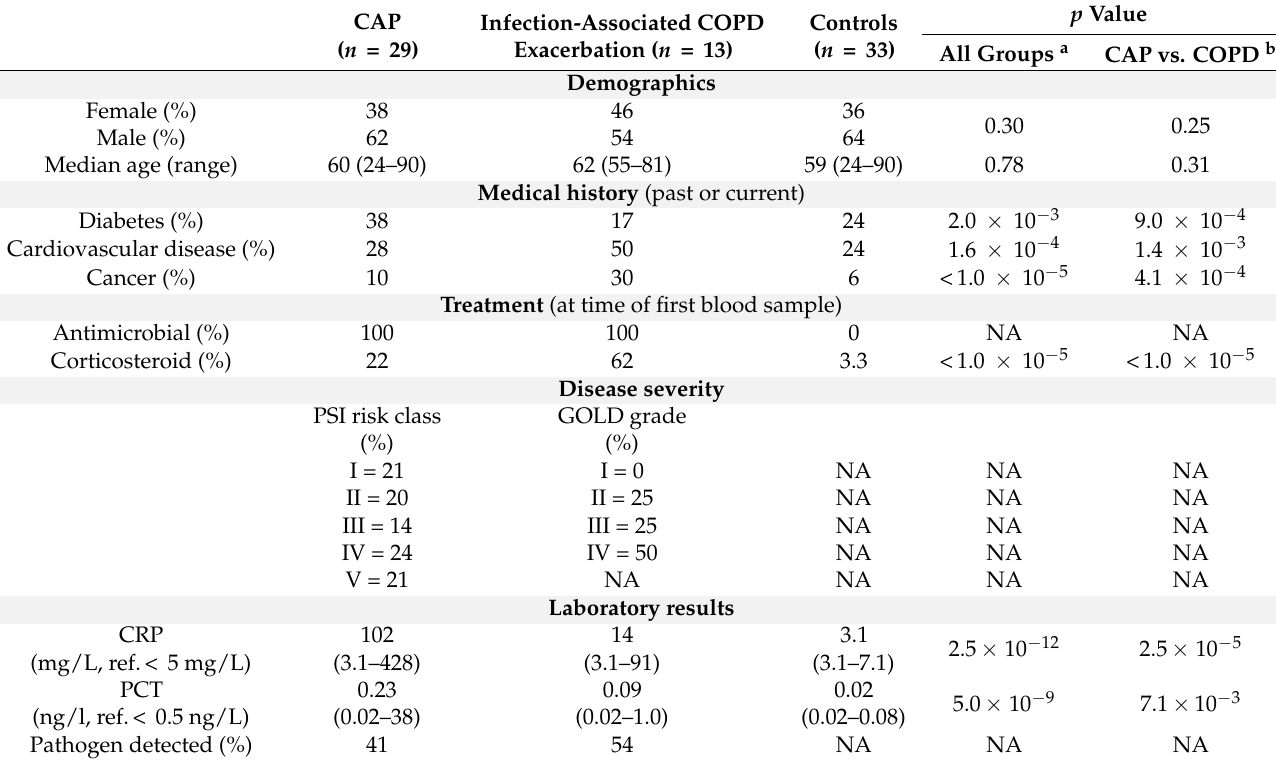
Table 1. Sociodemographic and clinical